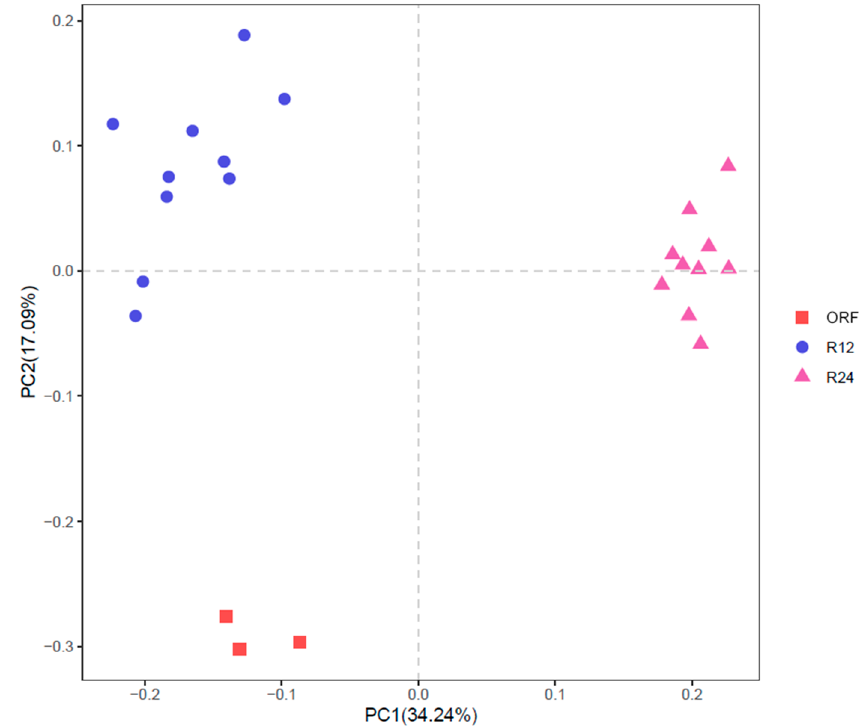
Figure 2. Principal component analysis (PCA) of rumen bacterial communities based on Euclidean distances. ORF, original rumen fluid; R12, in vitro rumen fermentation at 12 h; R24, in vitro rumen fermentation at 24 h.